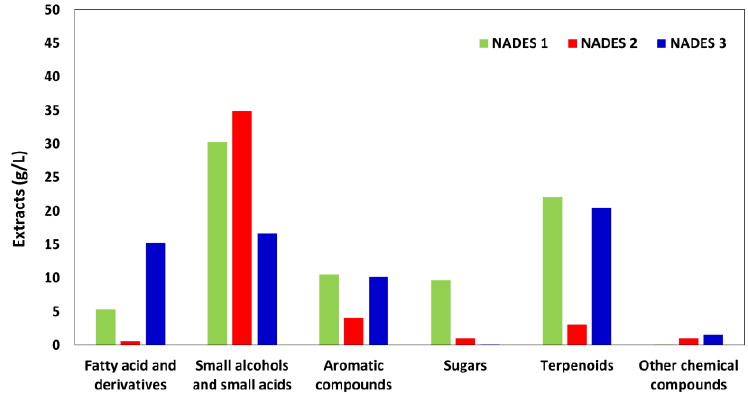
Figure 1. Extract concentrations (g/L) obtained from cork after extraction with NADES using a sealed system (0.7 g cork; 5 mL solvent; 100 °C; 6 h; three cycles using the sealed system).